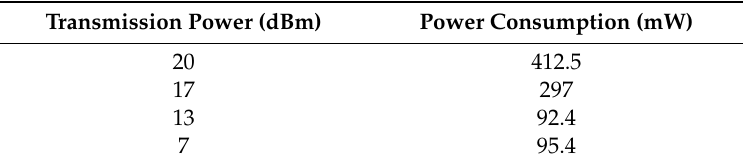
Table 2. LoRa SX1272 characteristics.